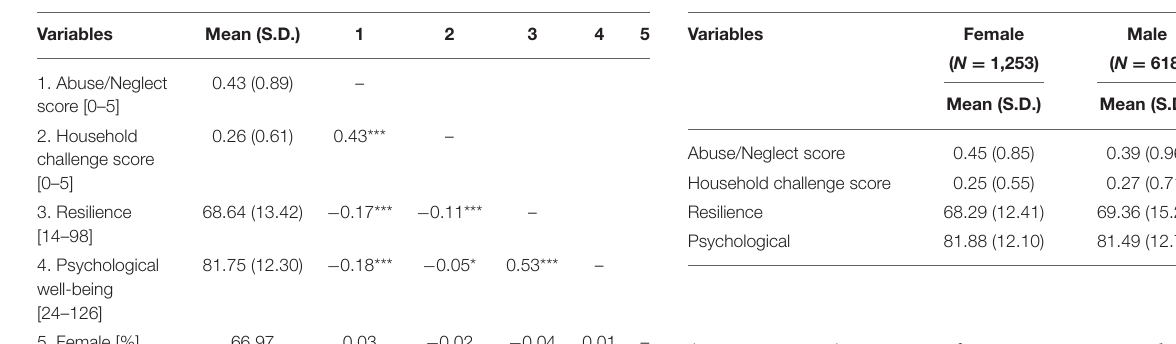
TABLE 1 | Descriptive statistics and correlations of main variables. TABLE 2 | Descriptive statistics for variables by